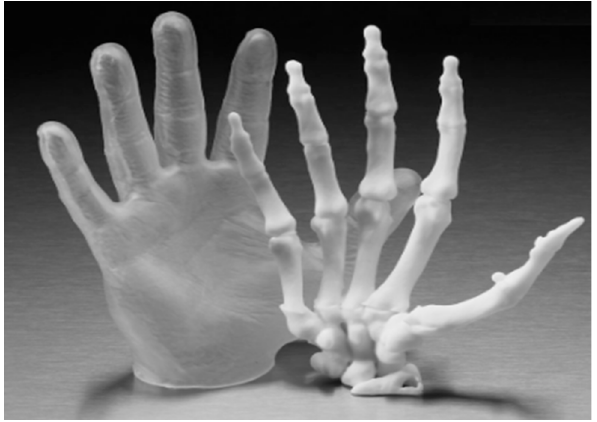
Figure 5. 3D anatomical model of hand–skin made of elastic 3D-printing material.